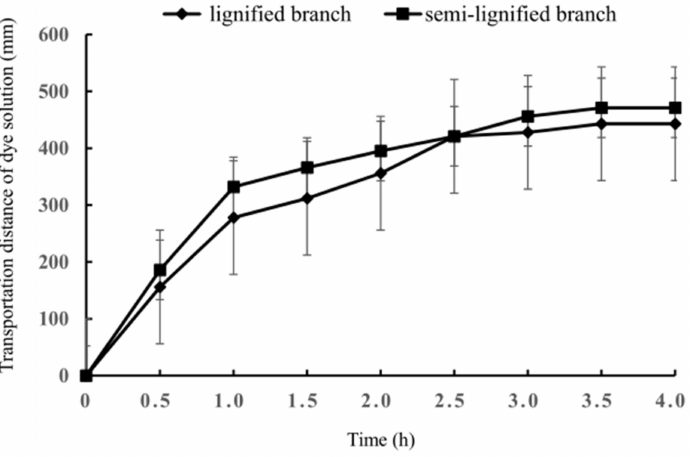
Figure 5. Transport rate of dye